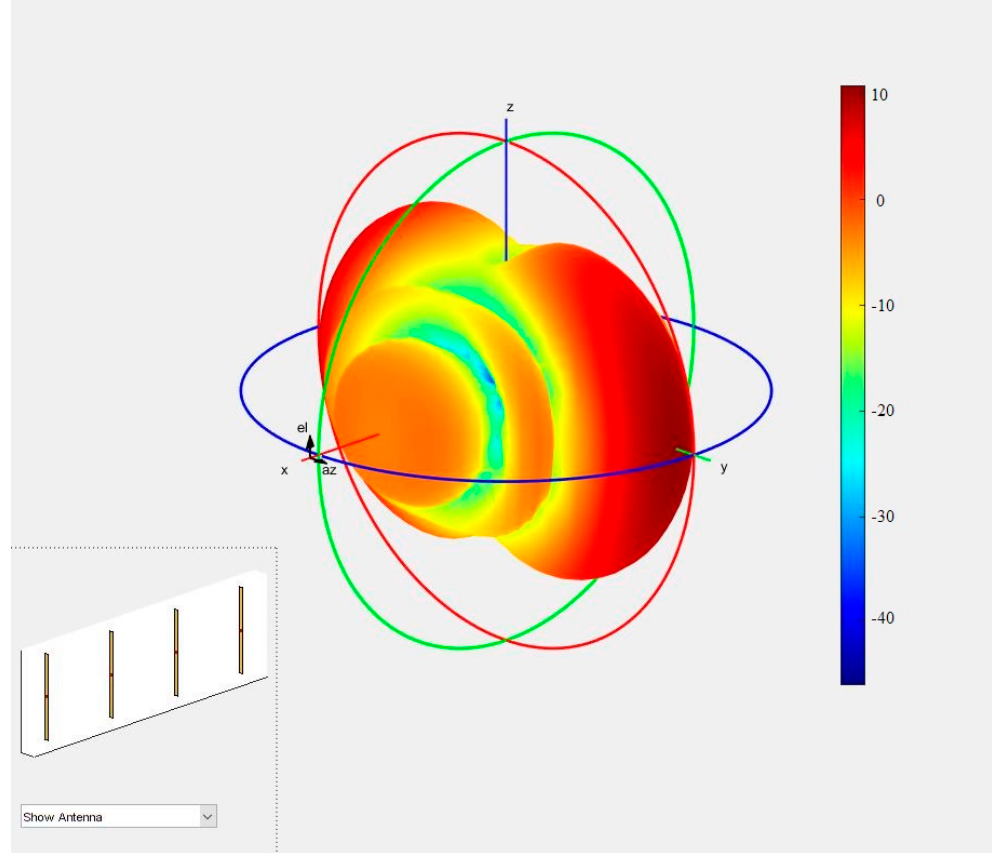
Figure 6. The radiation characteristics of the antenna used in the research for the 1554 MHz fre- quency.